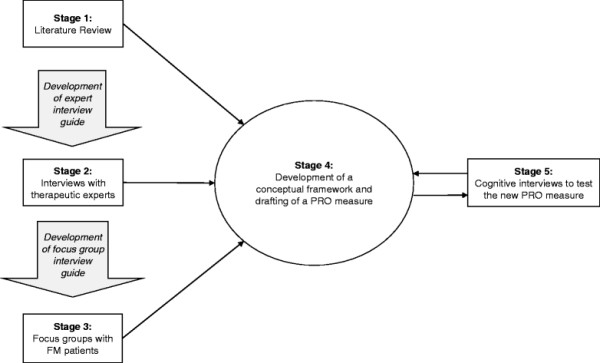
Study flow diagram.